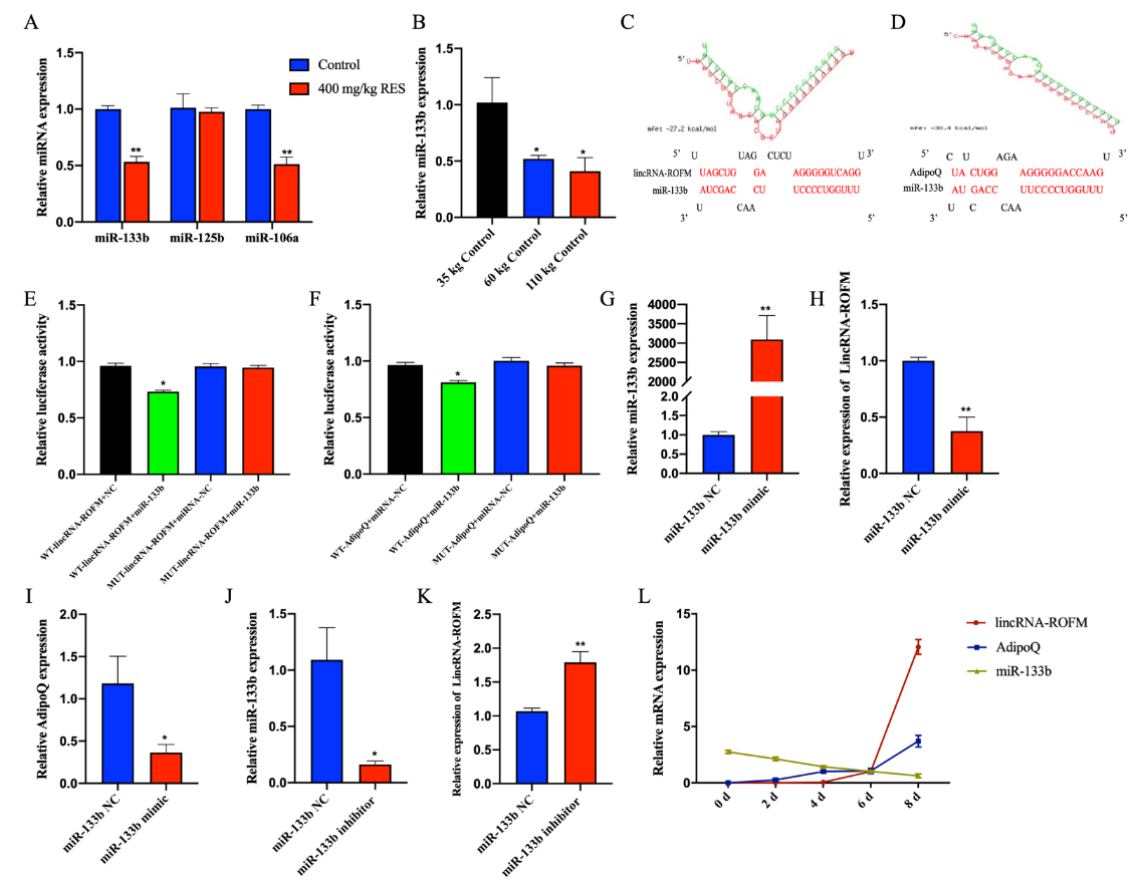
Figure 7. LincRNA-ROFM acts as a molecular sponge for miR-133b to regulate the expression of AdipoQ . ( A ) The expression profiles of miR-133b , miR-125b, and miR-106a in porcine subcutaneous fat in control and 400 mg/kg RES groups as detected by RT-qPCR assay. ( B ) The expression profiles of miR-133b in porcine subcutaneous fat in 35 kg, 60 kg, and 110 kg control groups as detected by RT-qPCR assay. ( C ) Complementary pairing between the sequences of LincRNA-ROFM and miR- 133b . The above scheme shows the calculated Δ G value. ( D ) Complementary pairing between the sequences of miR-133b and AdipoQ . The above scheme shows the calculated ∆ G value. ( E ) LincRNA- ROFM wild or mutant type psi-check2 plasmid was transfected into porcine preadipocytes together with miR-133b mimic. Luciferase activities were measured 24 h after transfection. ( F ) AdipoQ wild or mutant type psi-check2 plasmids were transfected into porcine preadipocytes together with miR-133b mimic. Luciferase activities were measured 24 h after transfection. ( G ) mRNA expression level of miR-133b in porcine preadipocytes after transfected with miR-133b mimics as detected by RT-qPCR assay. ( H ) mRNA expression level of LincRNA-ROFM in porcine preadipocytes after transfected